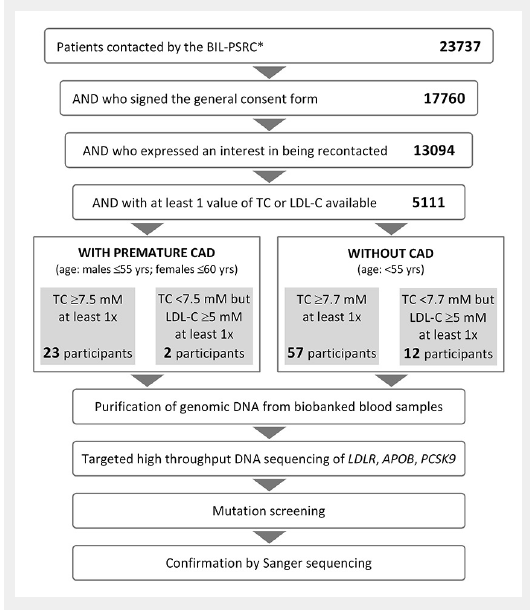
Selection scheme of 94 BIL participants for FH genetic testing and analysis workflow. *As of April 26, 2015. BIL = Lausanne Institutional Biobank; CAD = coronary artery disease; LDL-C = low-density lipoprotein cholesterol; PSRC = an integrated in-house clinical research support platform; TC = total